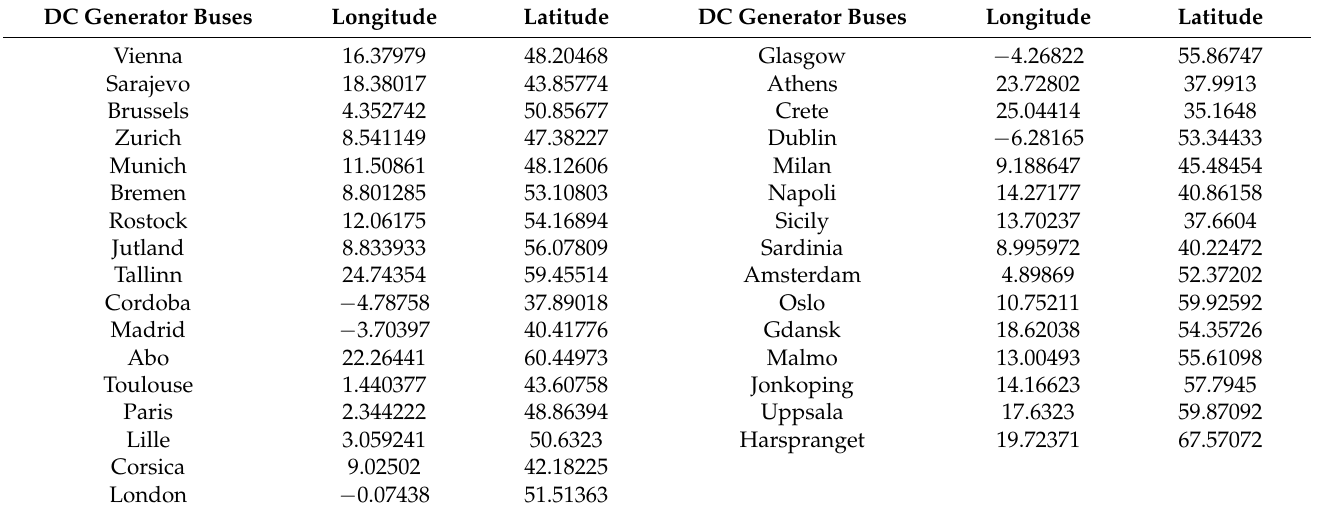
Table A2. DC load center buses.